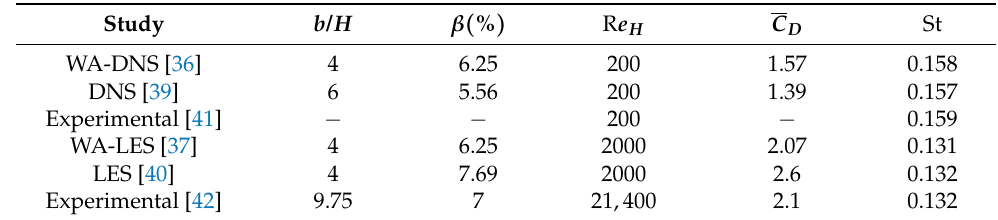
Table 2. Square-cylinder flow: comparison of WA-DNS and WA-LES results against reference numerical and experimental data.